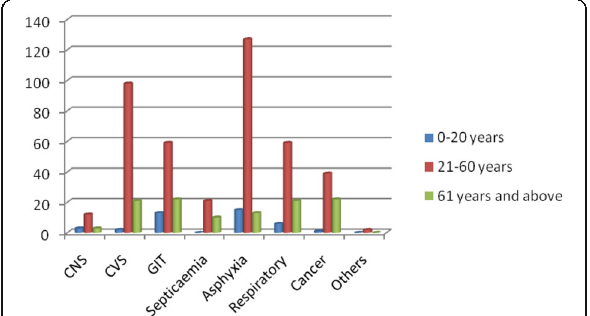
Fig. 1 Bar Chart showing the relative causes of Death with classified age groups. Shows that most death occurred in the 21 – 60 years age group. Cancer related deaths were very few in the younger age group which also showed no CVS and Septicaemia related deaths. Cardiovascular system related deaths with haemorrhage as the most common cause was majorly seen in the 21 – 60 years age